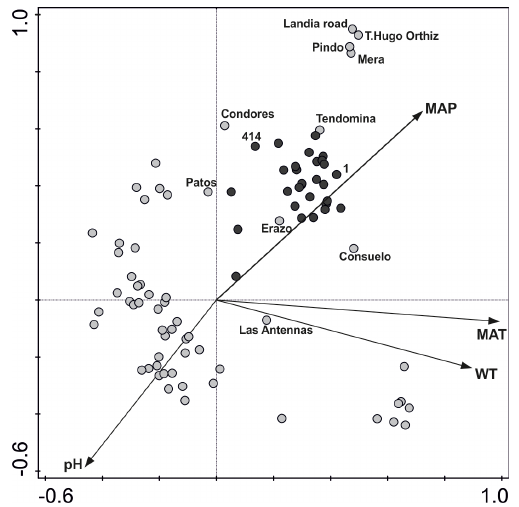
Figure 9. Distribution of Laguna Pindo fossil samples (black cir- cles) included passively within a CCA of the calibration data set lakes (grey circles) constrained using the significant environmen- tal variables. MAP: mean annual precipitation; MAT: mean annual temperature; WT: water temperature. The first and last fossil sam- ple in the sedimentary sequence has been labelled (total sediment depth); there are no directional trends through time. Calibration lakes that lie at similar elevations as Laguna Pindo have been la-